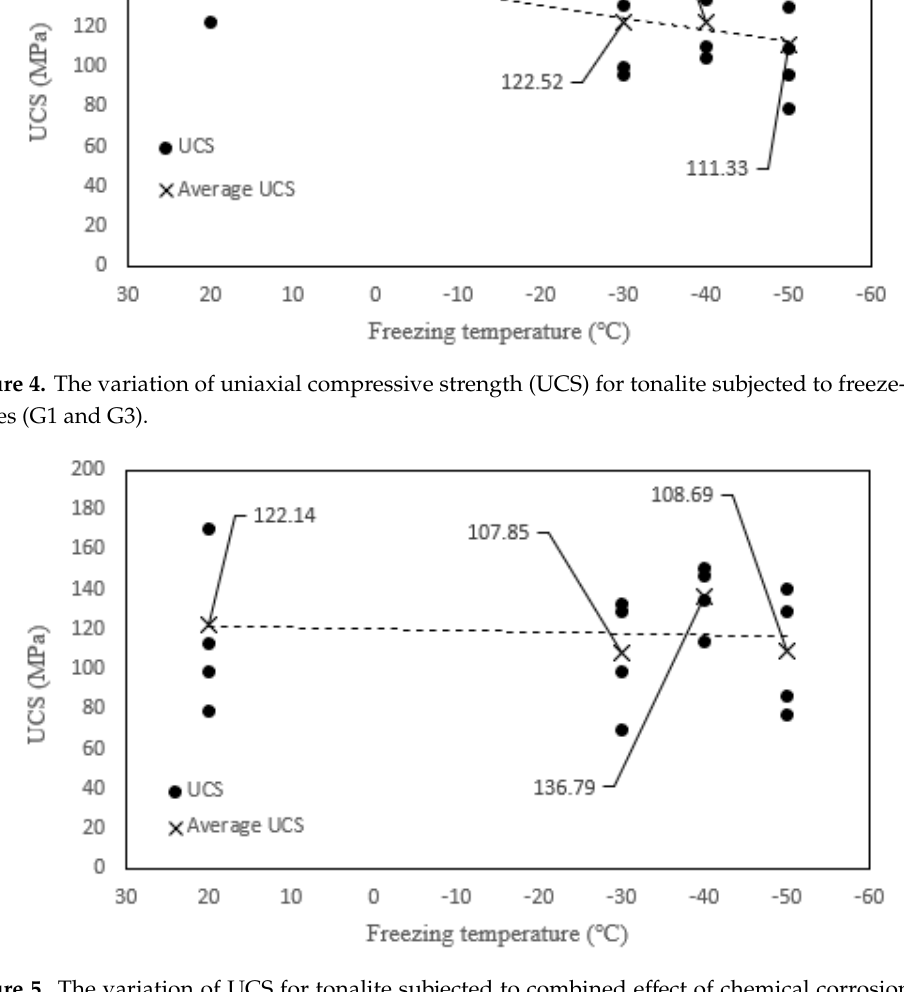
Figure 5. The variation of UCS for tonalite subjected to combined effect of chemical corrosion and freeze-thaw cycles (G2 and G4).